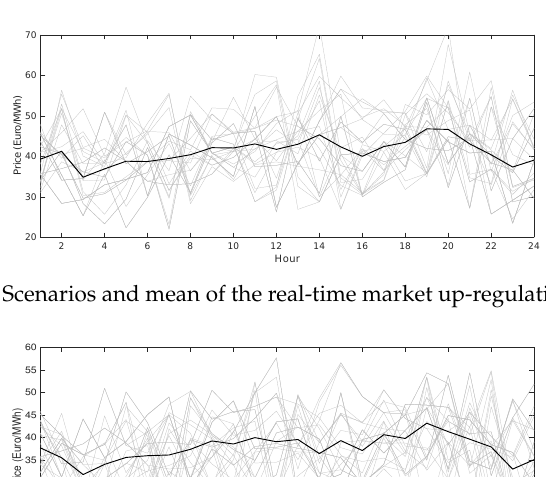
Figure 5. Scenarios and mean of the intra-day market buying prices.